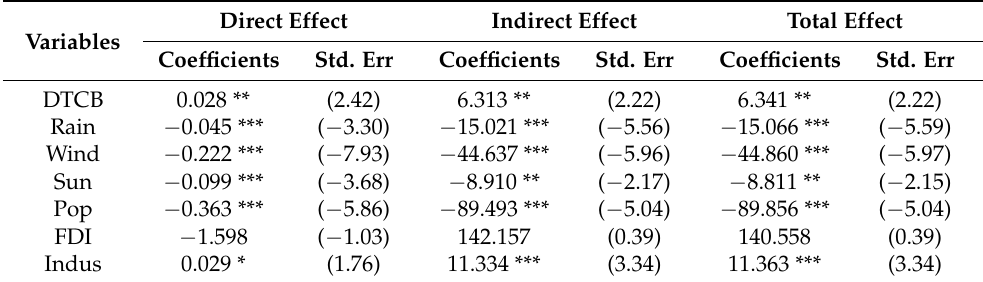
Table 5. Effects of spatial Durbin models for values in Table 4.